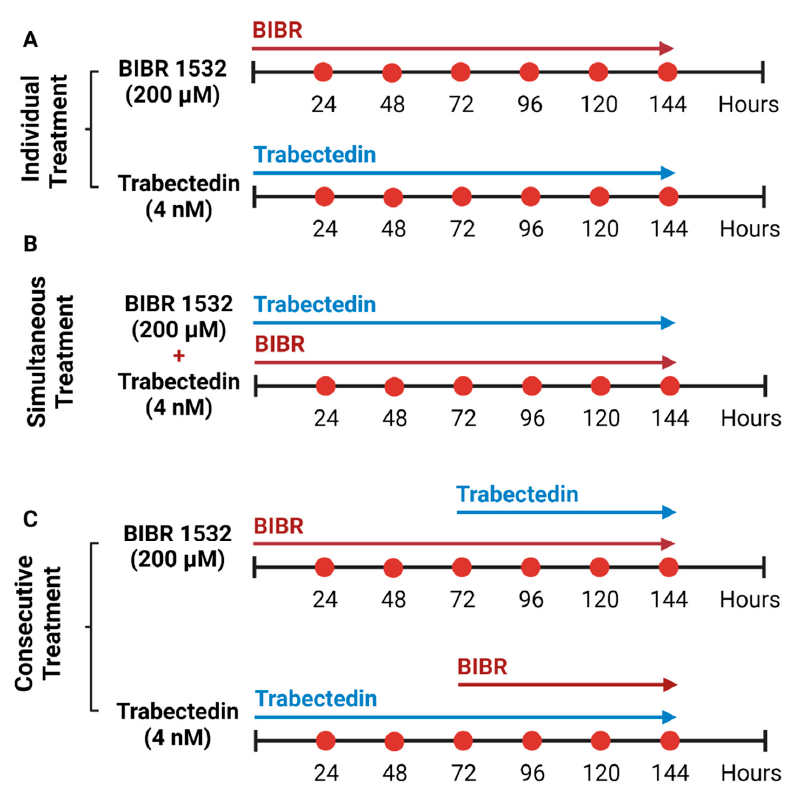
Figure 1. Inhibition of telomere maintenance pathways in HL cell lines. ( A ) Individual treatment of HL cell lines with 200 µ M of BIBR1532 and 4 nM of trabectedin for 144 h. ( B ) Simultaneous treatment of HL cell lines with 200 µM of BIBR1532 and 4 nM of trabectedin for 144 h. ( C ) Consecutive treatment of HL cell lines with BIBR1532 and trabectedin treatment, the latter was added after the first 72 h of BIBR1532. Consecutive treatment of HL cell lines with trabectedin followed by BIBR 1532, which was added at the 72 h time point.